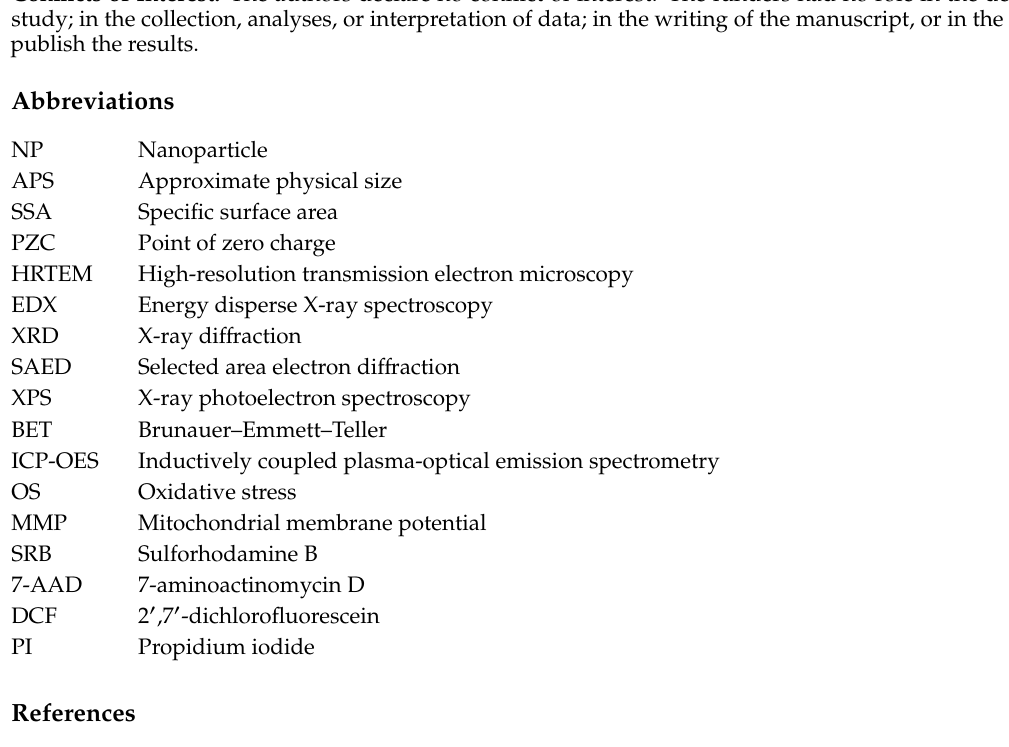
Ni(OH)2. Figure S3: Exemplary flow cytometer data in FCS Express 6. Table S1: Point of Zero Charge. Table S2: HepG2